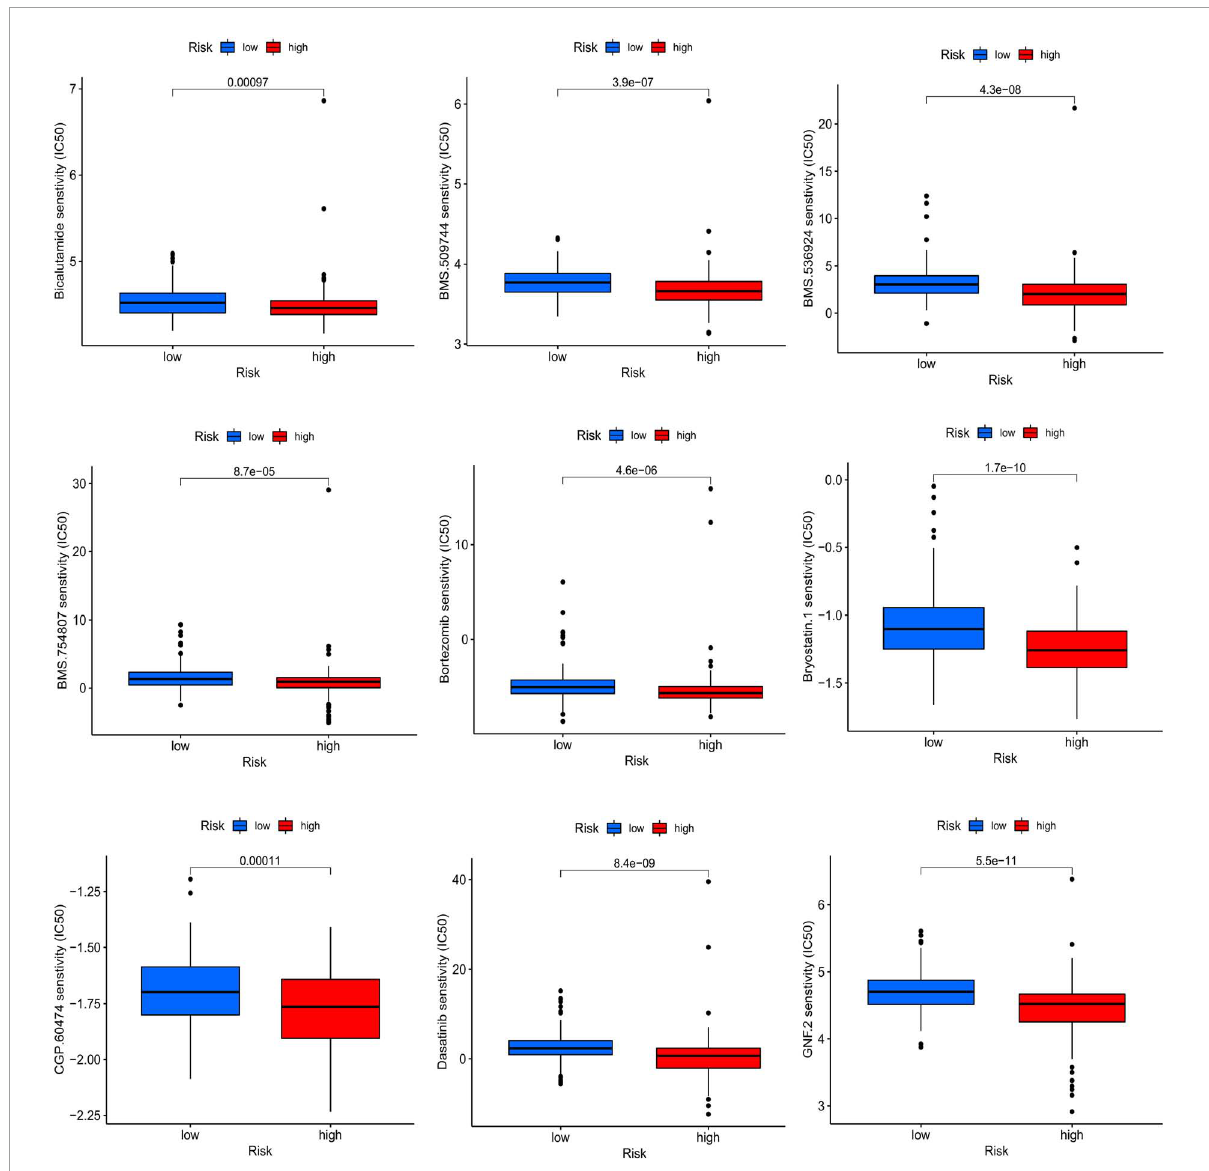
FIGURE9 Drug sensitivity analysis between high- and low-risk